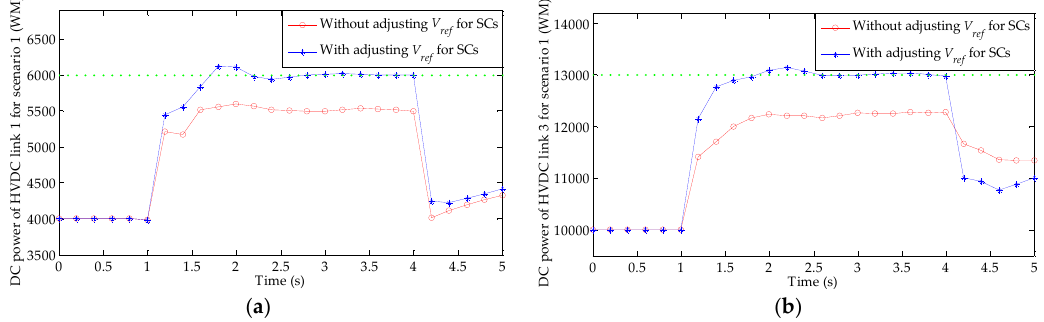
Figure 5. Effectiveness of adjusting V ref during DC power support. ( a ) DC power curves of HVDC Link 1 for Scenario 1; and ( b ) DC power curves of HVDC Link 3 for Scenario 1.